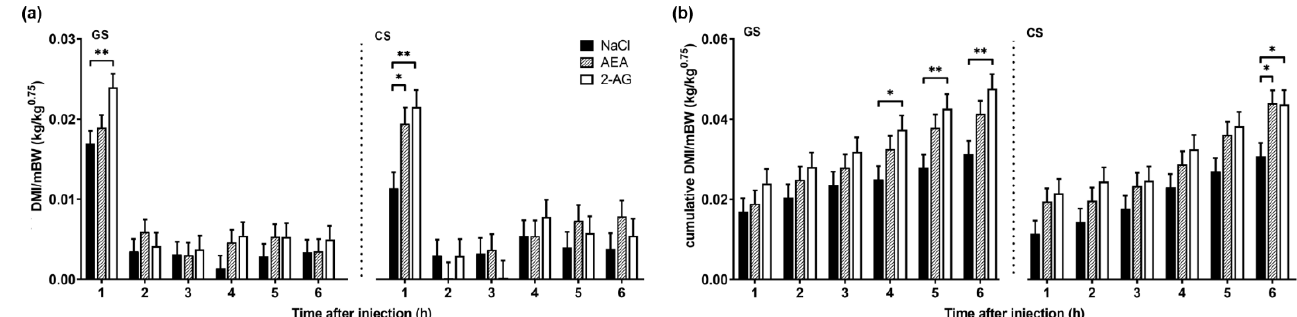
Figure 1. Dry matter intake per metabolic body weight DMI/BW 0.75 ( a ) and cumulative DMI/BW 0.75 ( b ) on day 8, 1 to 6 h after intraperitoneal administration with NaCl ( n = 7), AEA ( n = 7) or 2-AG ( n = 6). Cows were fed ad libitum a grass silage (GS) and corn silage (CS)-based diet. Data are shown as LSM ± SE. Treatment differences are indicated by * p < 0.05 and ** p < 0.01 (Tukey–Kramer). ANOVA results are presented in Table S3.